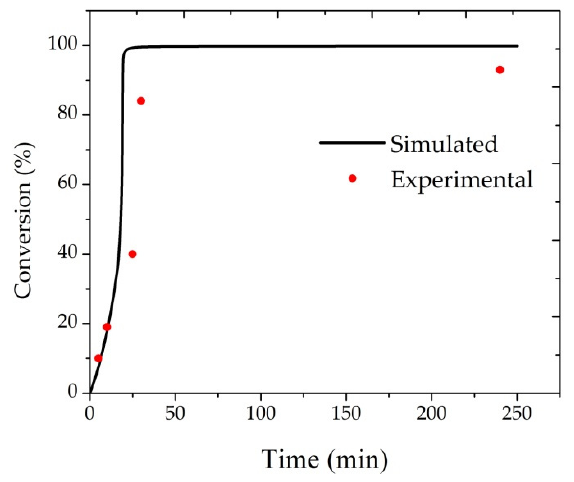
Figure 1. Monomer conversion, as provided by the model and reported by Santos [23].